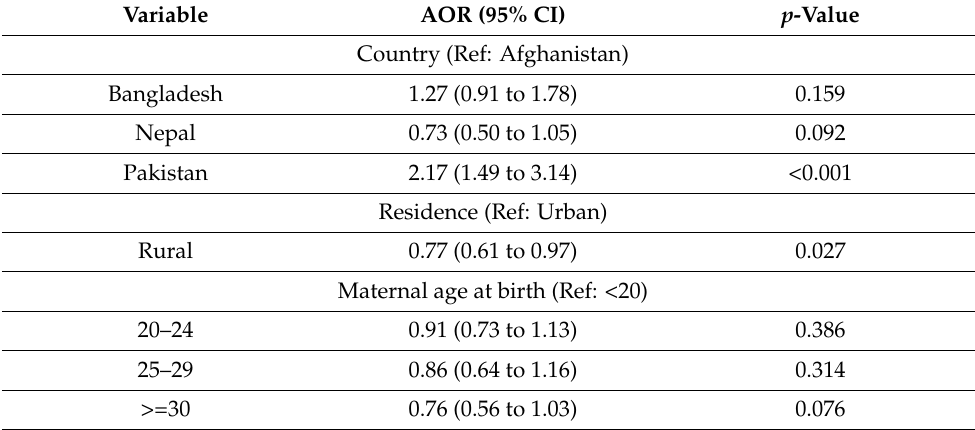
Table 2. Results of the logistic regression model fitted to LBW with sociodemographic factors, adjusting for survey